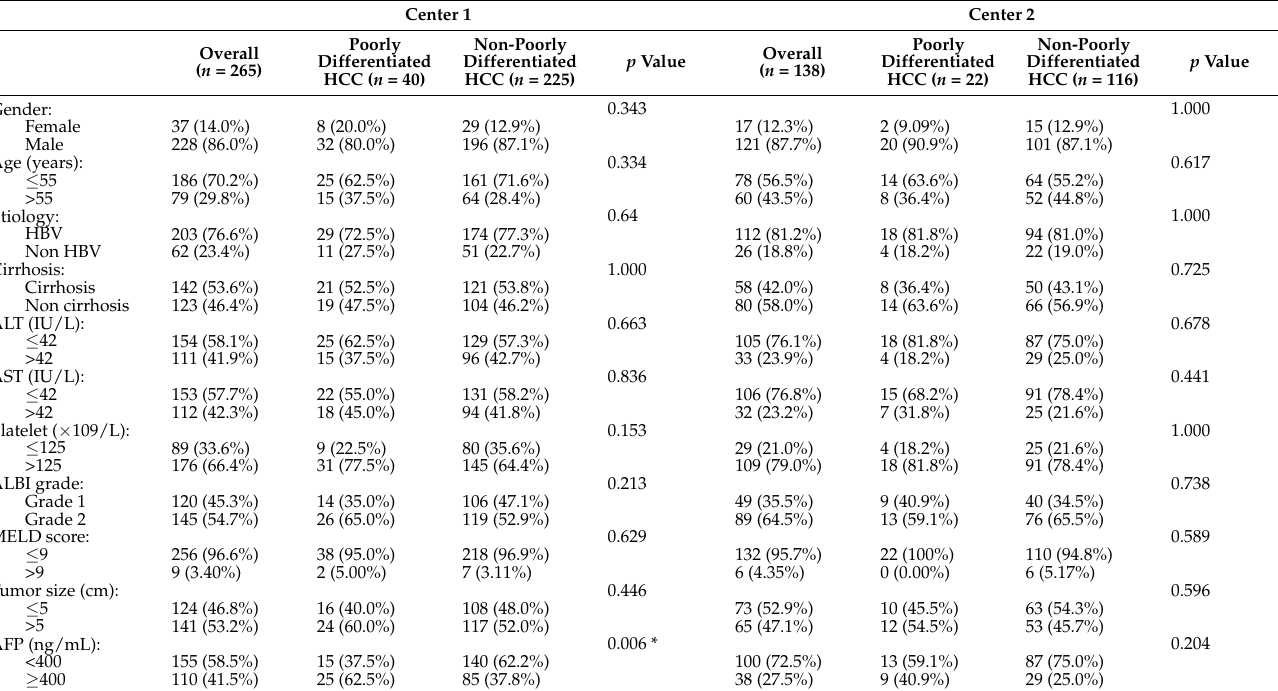
Table 1. Basic characteristics of the patients in the development and test